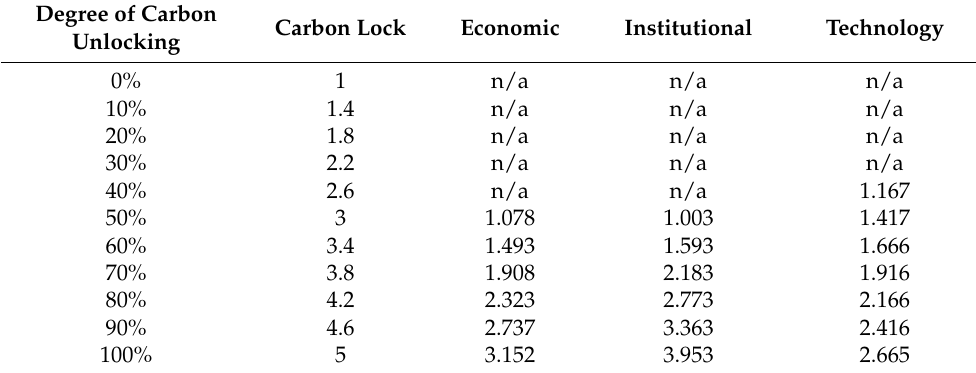
Table 10. Bottleneck analysis